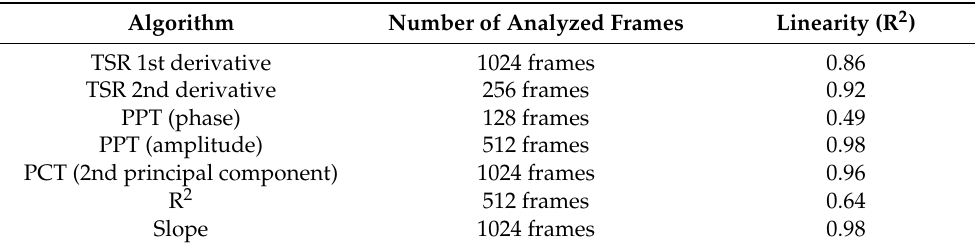
Table 4. Comparison among the different algorithms in terms of the linear correlation between SBC and r.